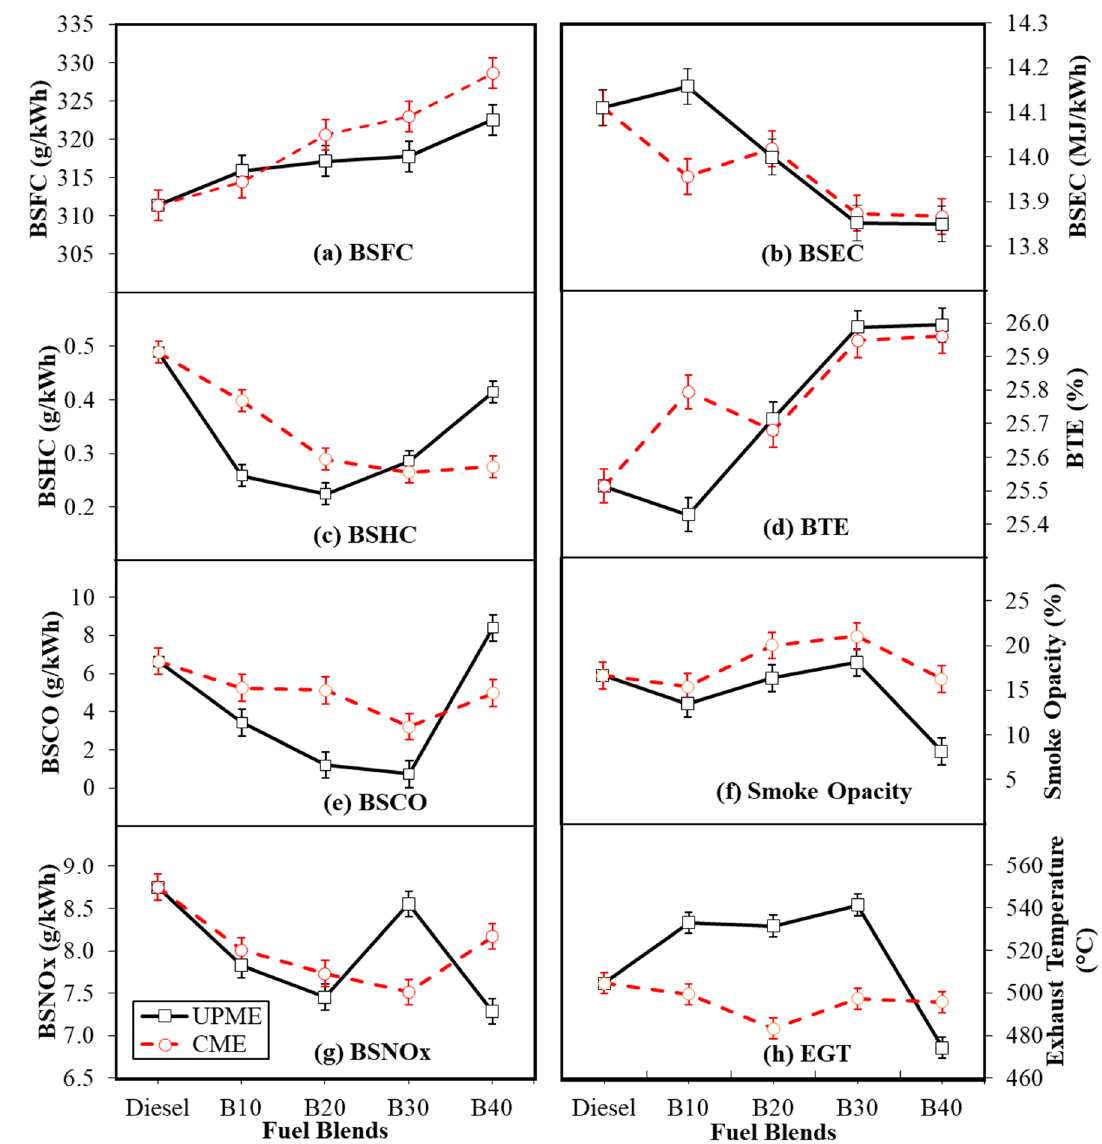
Figure 2. Performance and emission characteristics of various fuel blends compared with diesel fuel.